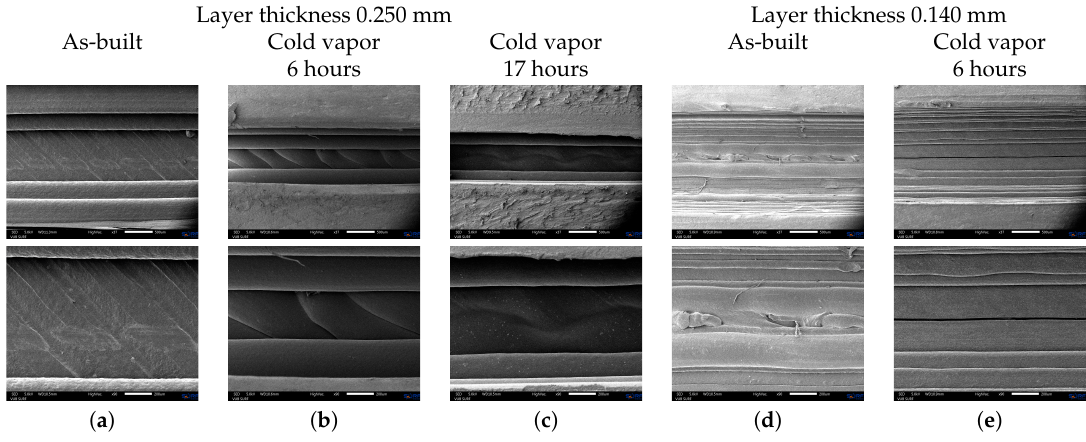
Figure 4. Scanning Electron Microscope (SEM) images of capillary surface inside ABS printed tensile test samples with layer thickness of 0.250 mm for ( a ) as built condition ( b ) cold vapor treatment during 6 h ( c ) cold vapor treatment during 17 h and with layer thickness of 0.140 mm for ( d ) as-built condition and ( e ) cold vapor treatment during 6 h.